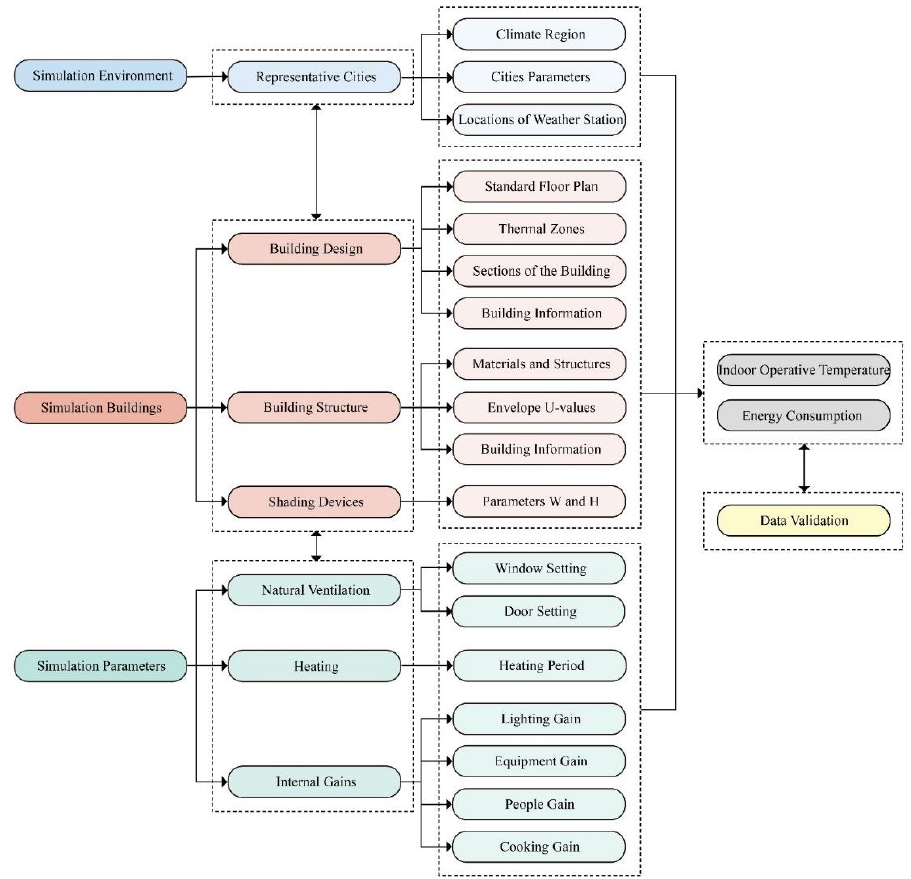
Figure 4. Flowchart of the building simulation; drawn by the authors.